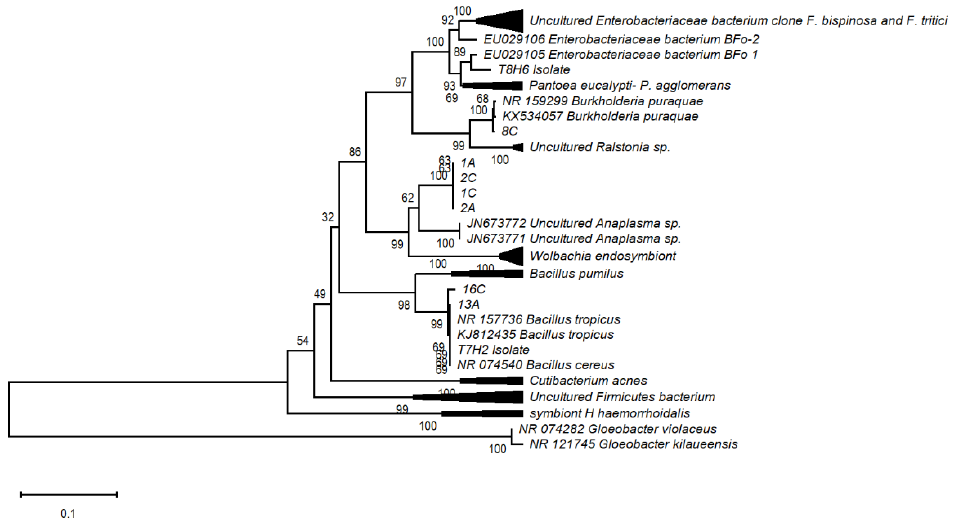
Figure 4. Dendrogram of sequences of the 16S rDNA bands (~400 bp) obtained from the profiles (PCR- TGGE), together with sequences from GenBank. The dendrogram was constructed using the neighbor- joining method and the Kimura 2-parameter model. The numbers on the nodes represent bootstrap values. The robustness of the phylogeny was tested by bootstrap analysis using 1000